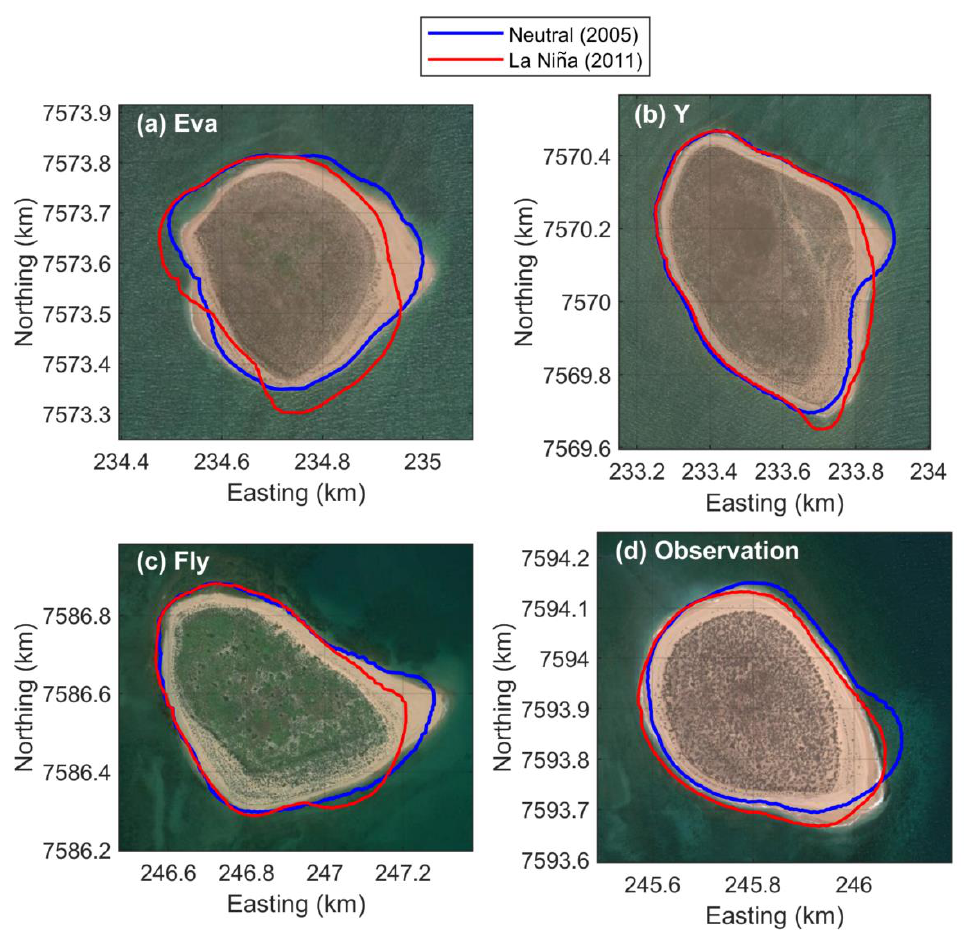
Figure 7. Interannual shoreline variability: ( a – d ) annually averaged shoreline position at each island for 2005 (blue line), an ENSO neutral year; and 2011 (red line), a strong La Niña year.